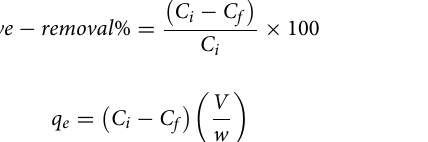
FTIR. Figure 1 represents the FTIR spectra of NiFe 2 O 4 , MMT, AmCs, and MMT-mAmCs composite. The FTIR curve of NiFe 2 O 4 illustrates the absorbance peaks at 604